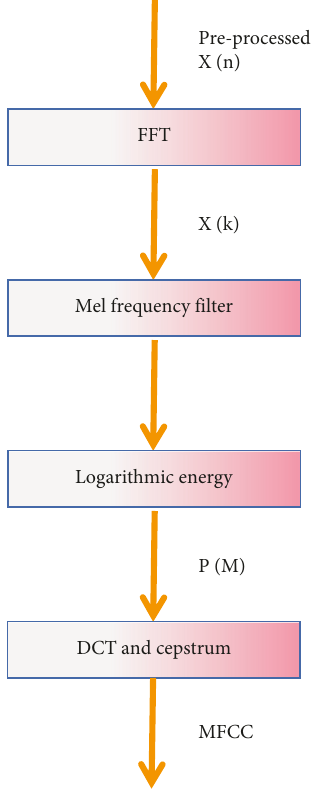
Figure 2: MFCC feature